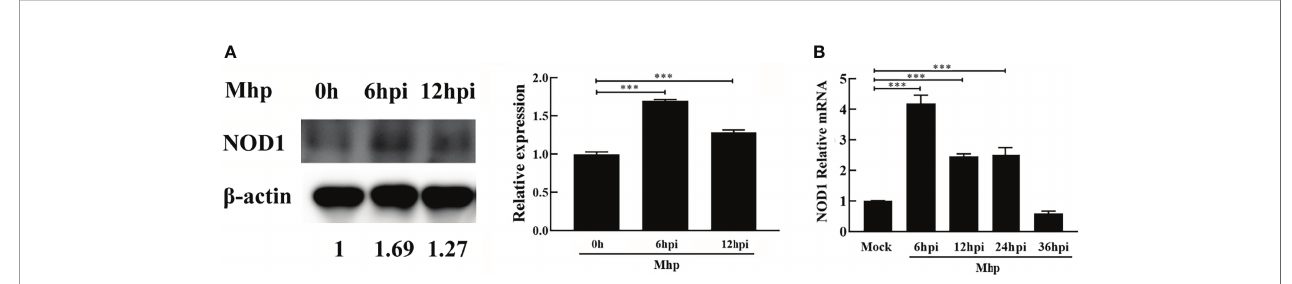
FIGURE 1 | M. hyopneumoniae infection triggers NOD1 transcription and steadily up-regulates NOD1 protein abundance. (A) M. hyopneumoniae infection up- regulates NOD1 protein abundance. (B) M. hyopneumoniae infection triggers NOD1 transcription. ***P < 0.001 indicate statistically signi fi cant differences among different